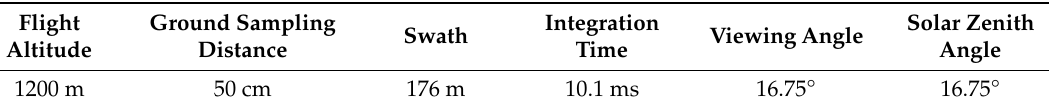
Table 2. Parameters of the aerial